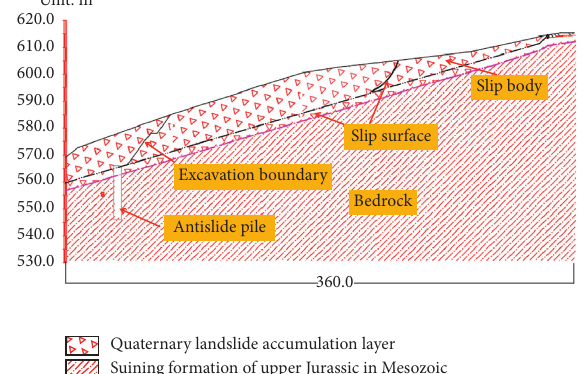
Figure 2: No. 2-2 ′ landslide engineering geological section (unit: m).